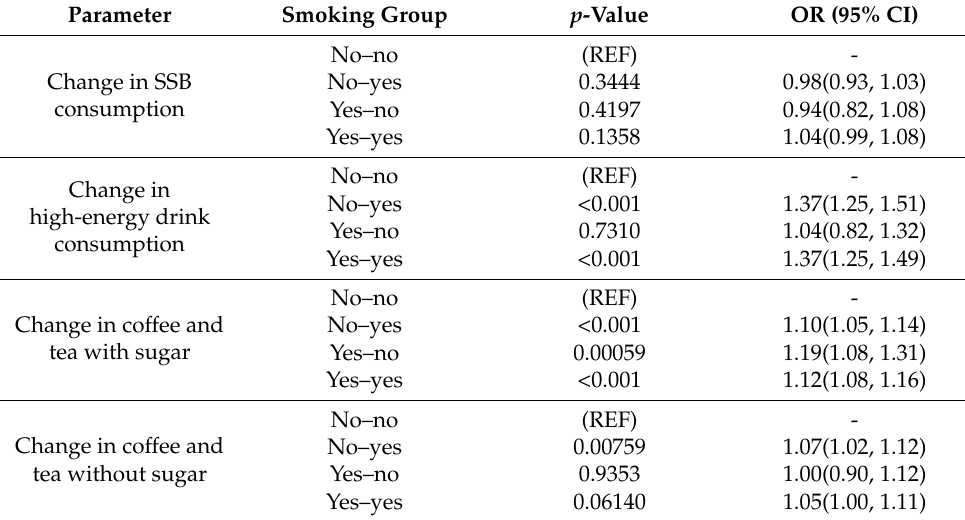
Table 5. Model 1: Longitudinal association between change in beverage consumption (2016/17– 2017/18) and smoking initiation (2016/17–2017/18) in the COMPASS study.